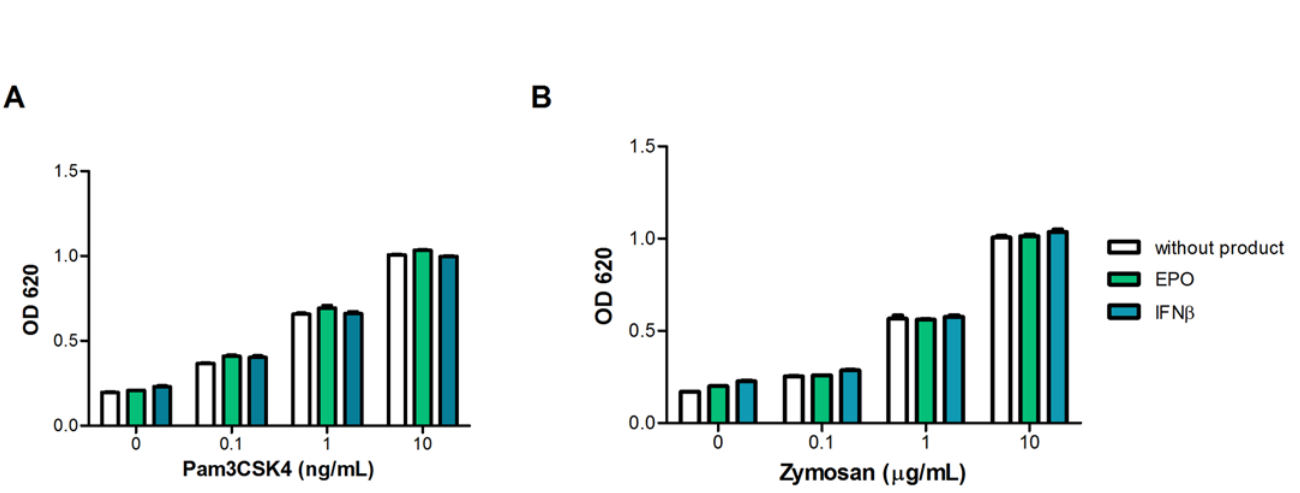
Fig 5. Therapeutic proteins don ’ t modify the LLOD in RAW — BLUE cells. RAW-BLUE cells were stimulated with indicated concentration of ( A ) Pam3CSK4 ( B ) Zymosan in the presence or absence of erythropoietin (1000IU/mL) and IFN β (1000IU/mL) for 24h. NF- κ B activation was assessed in the culture supernatant as described in materials and methods. Each point represents mean ± SD of triplicate cell culture.